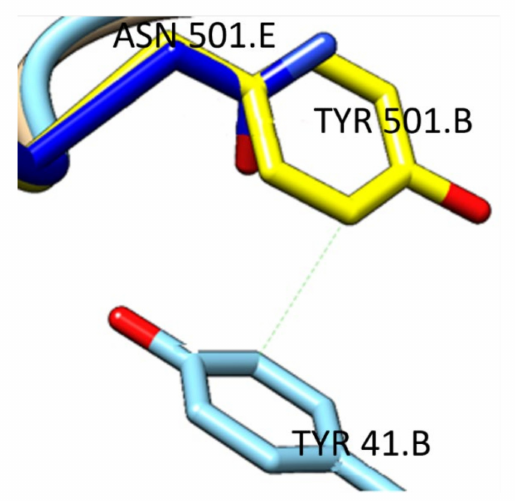
Figure 9. Asparagine-501 from wild-type RBD (PDB 6M0J, carbon atoms in blue) and tyrosine-501 from Gamma variant (PDB 7NXC, carbon atoms in yellow), capable of establishing an additional pi-stacking interaction with tyrosine-41 from hACE2 (bottom)